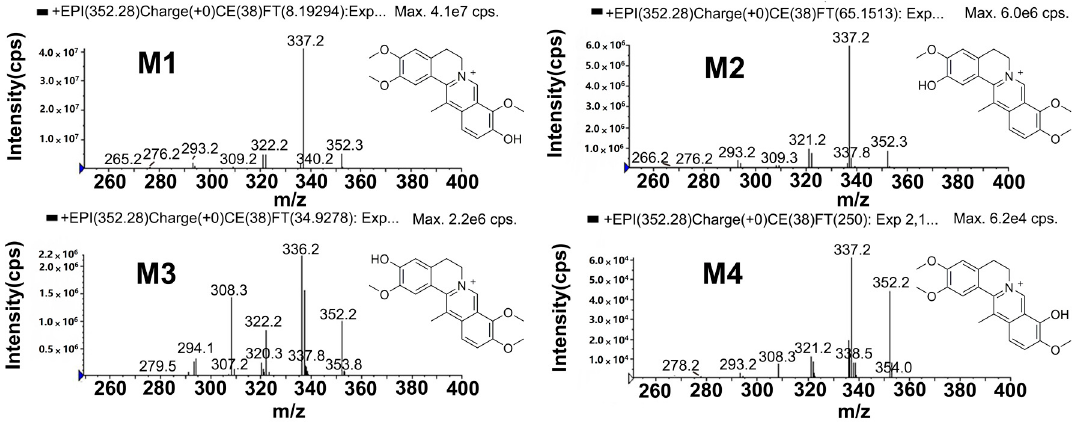
Figure 4. The mass spectrometry (MS 2 ) spectra of 13-methyl-dehydrocorydalmine ( M1 ), 13-methyl- columbamine ( M2 ), dehydrocorybulbine ( M3 ) and 13-methyl-palmatrubine ( M4 ). 2.5.2. Metabolites Produced by Glucuronidation of O -Demethyl-DHC (M5, M6 and M7) M5 ( t R = 4.4 min), M6 ( t R = 5.0 min) and M7 ( t R = 5.5 min) had molecular ions (Figure 5) at m / z 528,